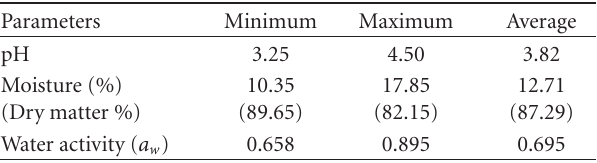
Table 4: pH, moisture, and water activity results of analyzed tarhana